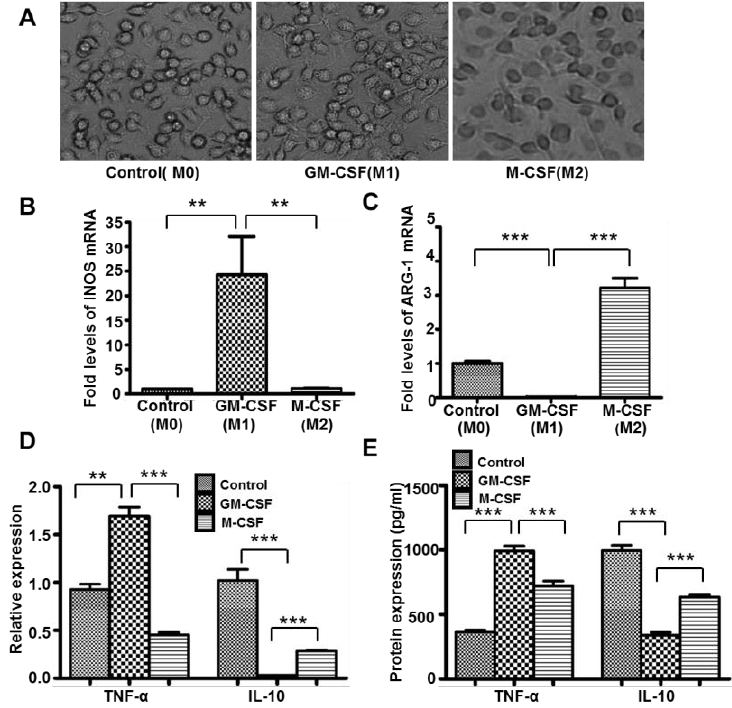
Figure 1. Macrophage polarization was induced successfully in vitro . Macrophages’ morphology was observed by light microscope, (M0) control macrophages (untreated macrophages); (M1) macrophages stimulated with GM-CSF; (M2) macrophages stimulated with M-CSF ( A ). Original magnification ×400. INOS ( B ), ARG-1( C ), IL-10 and TNF-α ( D ) mRNA expression were detected by qRT-PCR. IL-10 and TNF-α ( E ) protein expression were detected by ELISA. n = 4, ** p < 0.01, *** p < 0.001. M0: Macrophages with no treatment; M1: Macrophages treated with GM-CSF; M2: Macrophages treated with